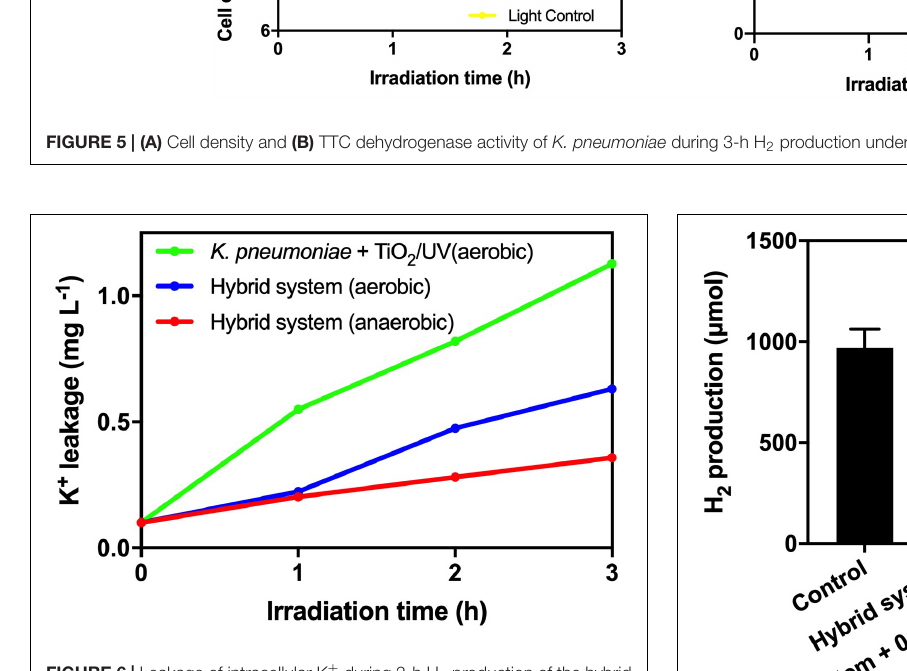
FIGURE 6 | Leakage of intracellular K + during 3-h H 2 production of the hybrid system in anaerobic and aerobic conditions under 2,000 W m − 2 VL irradiation and photocatalytic inactivation of K. pneumoniae with 1 g L − 1 TiO 2 under UV irradiation.